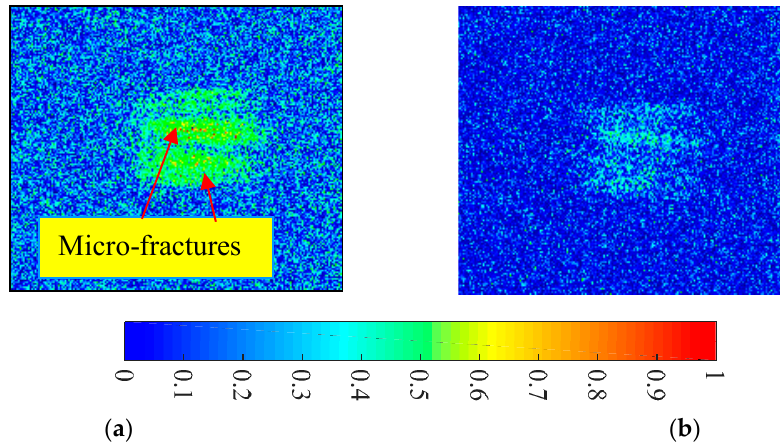
Figure 8. NMR imaging: ( a ) 0 h and ( b ) 59 h. The color bar can reflect oil saturation.